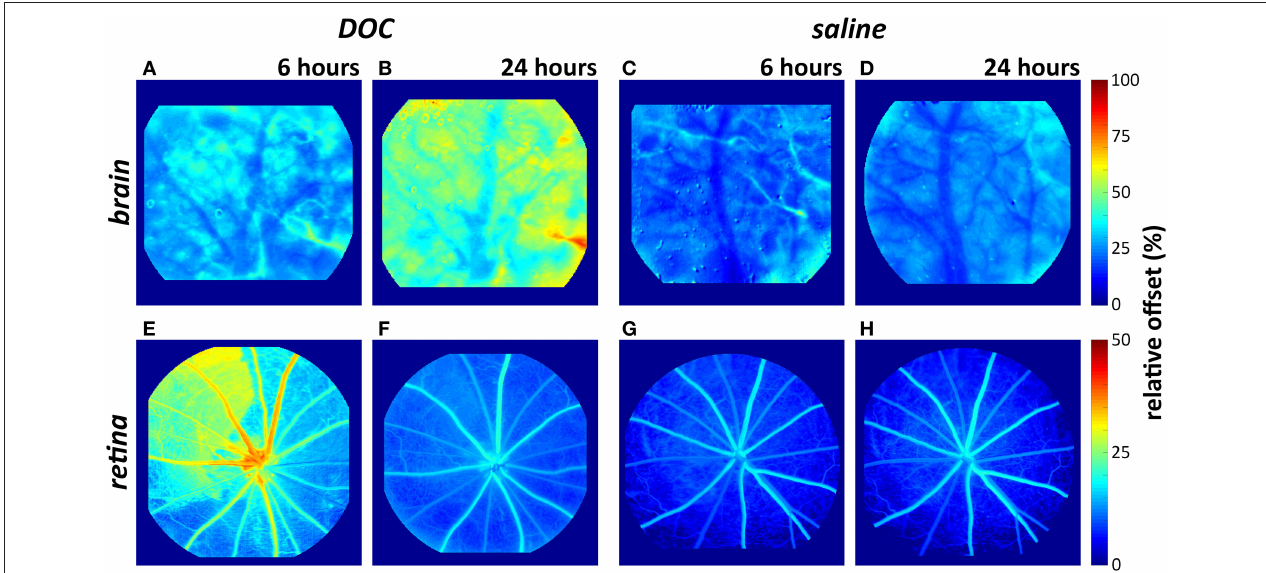
FIGURE 4 | Representative color maps demonstrating changes to the “offset” in the brain (A–D) and retina (E–H) after DOC or saline infusion. The retinal vasculature showed an elevated offset (i.e., increased fluorescein retention) at 6h but not 24h. The cortical vasculature showed an elevated offset 24h after DOC administration (warm colors in B